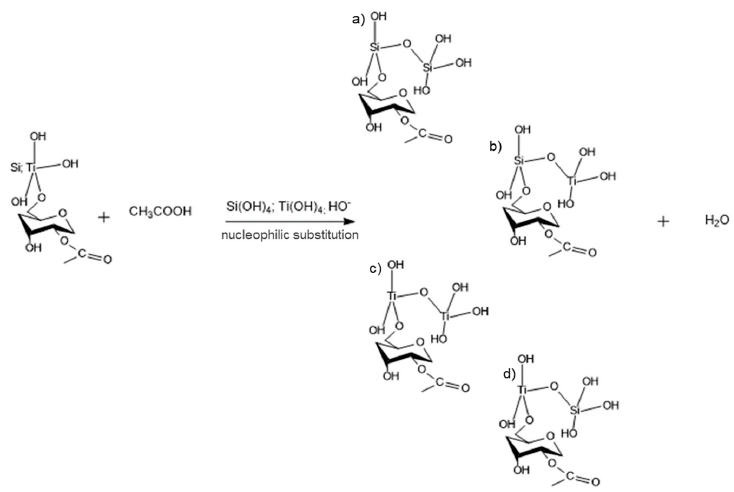
Figure A9. Further condensation reactions between Si(OH) 4 and / or Ti(OH) 4 molecules with other inorganic molecules already bonded to the CA polymer.